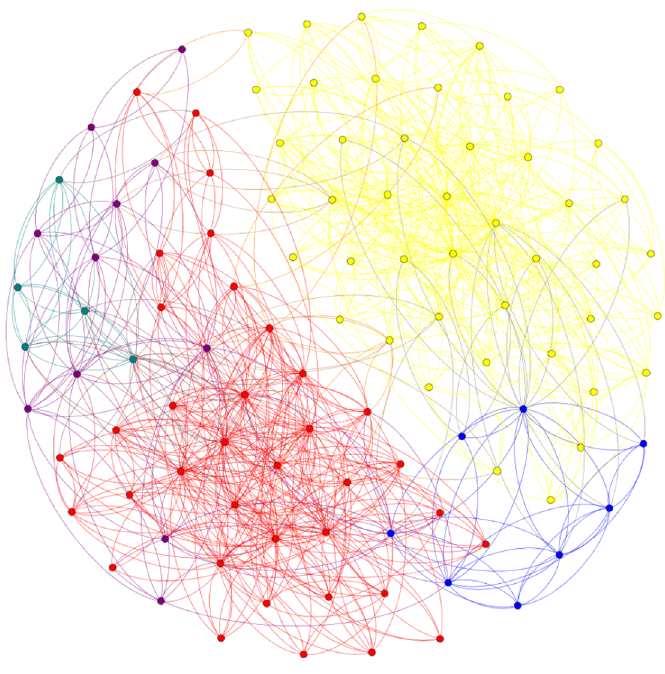
Fig 11. Political books dataset: A solution reported by p MNEO with NMI = 0.52 and verified to be a Nash equilibrium; some of the ‘difficult’ nodes are placed in a different community.